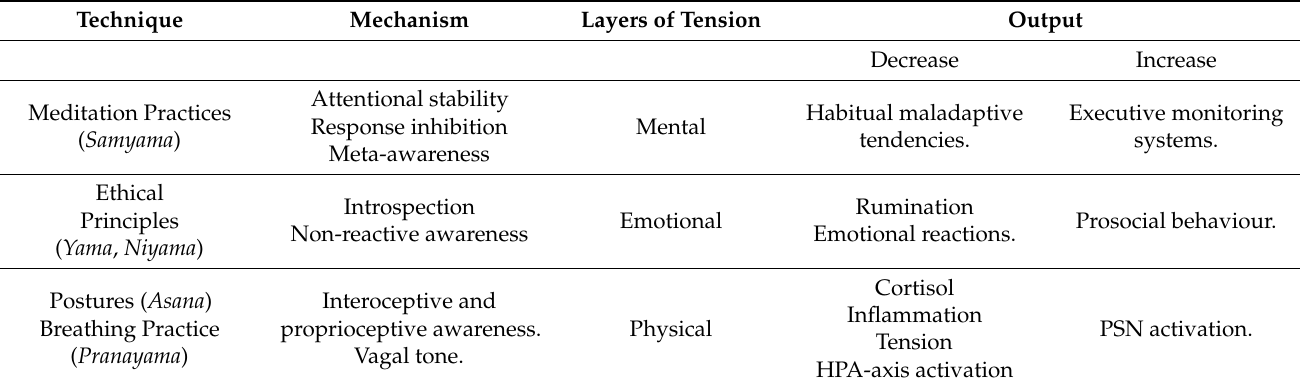
Table 1. Techniques from the System of Yoga * and stress